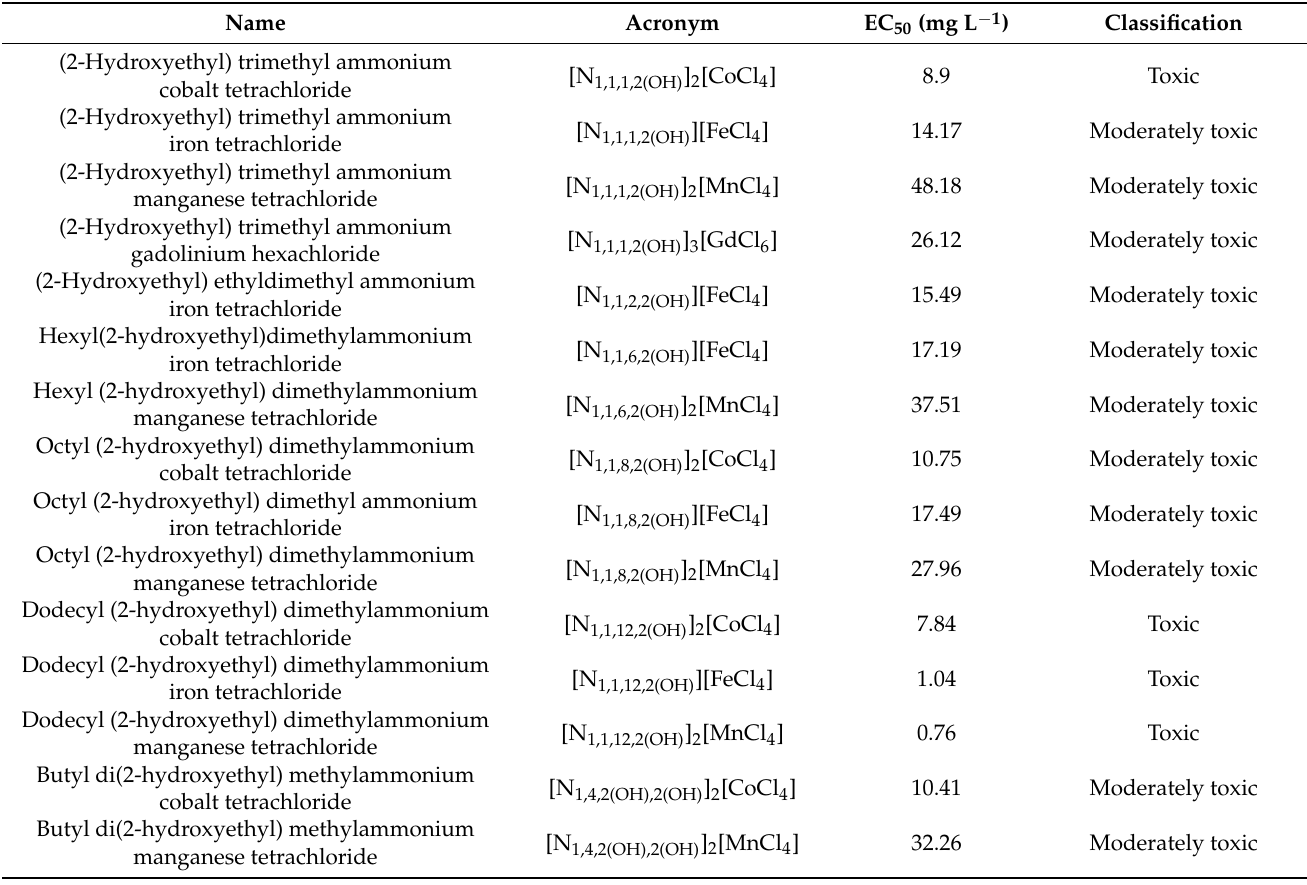
Table 1. EC 50 values (30 min of exposure) for the ILs towards A. fischeri studied by Sintra et al.